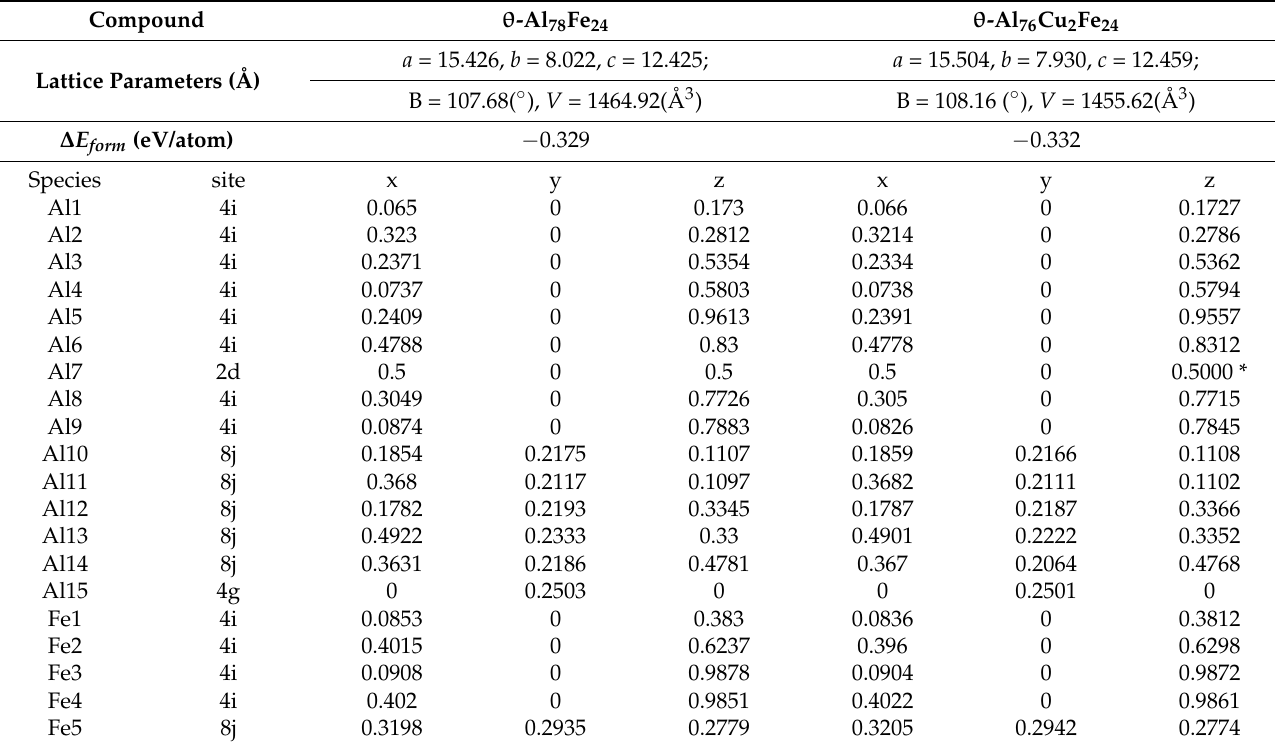
Figure 6. (Color on line) The pDOS of the selected atoms and tDOS curves for the binary θ -Al 78 Fe 24 ( a ) and the θ -Al 76 Cu 2 Fe 24 phase ( b ). For the pDOS, a) to f) and h) to m), the green curves represent contributions from the s-character states, blue the p-character, red the d-character and black the sum of the s, p and d states of the atoms.